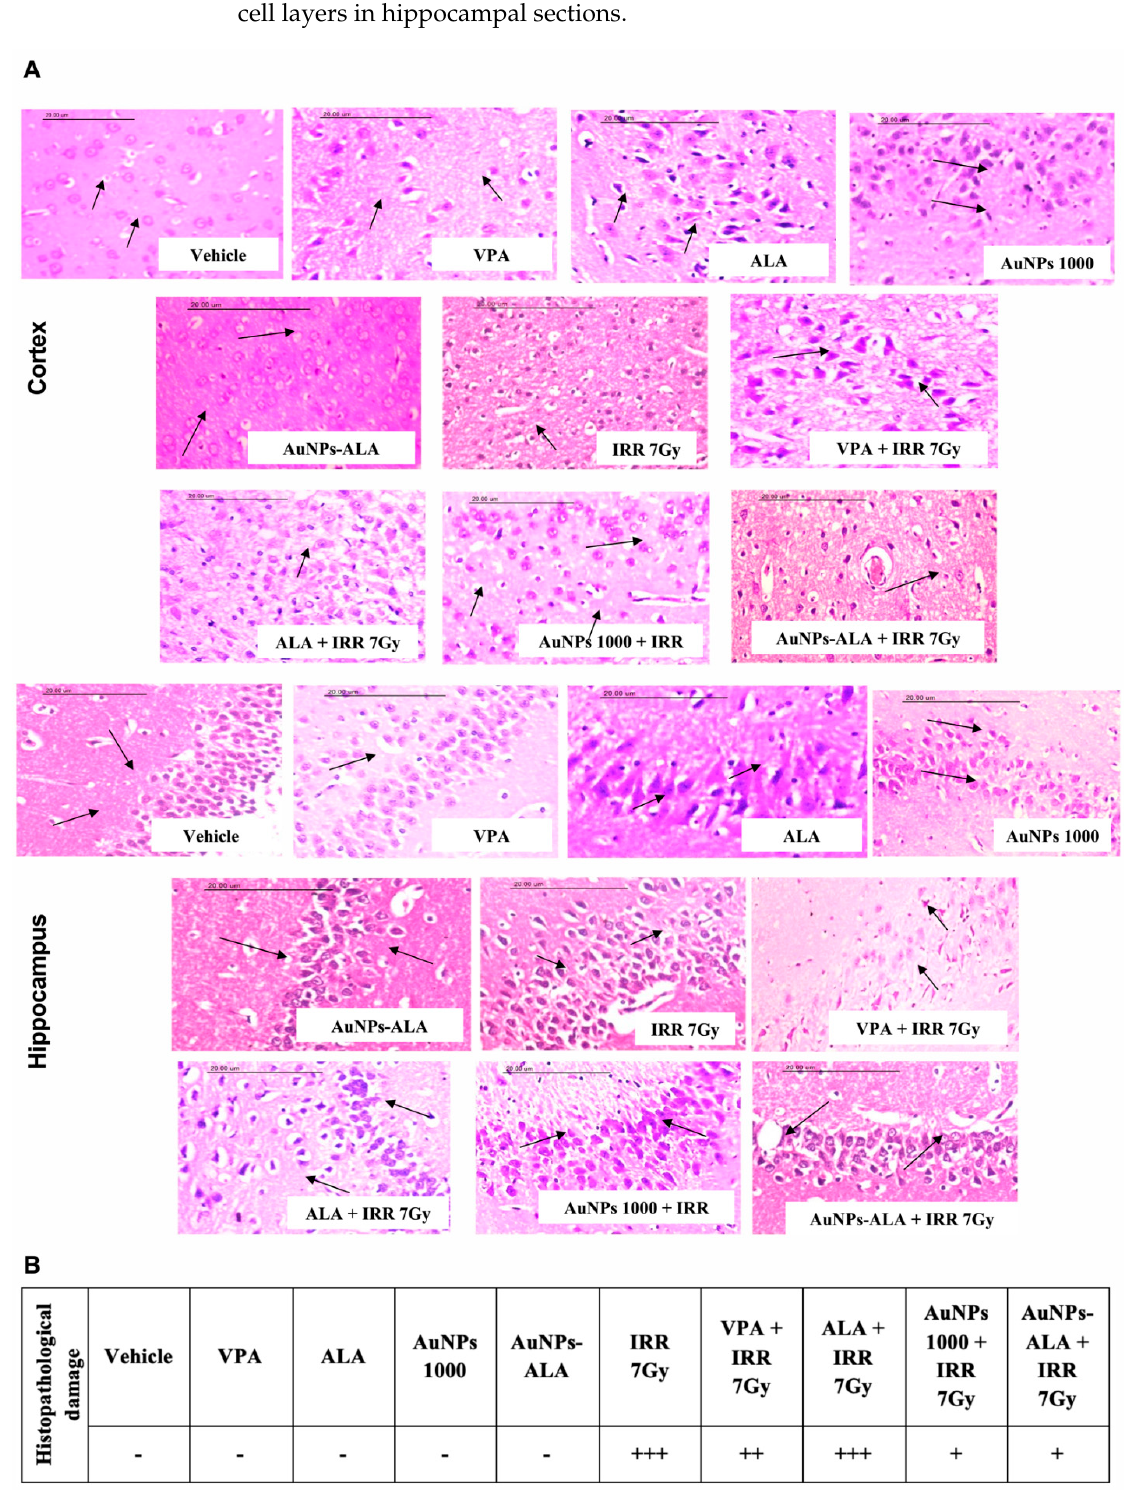
Figure 11. Effect of single oral administration of AuNPs-ALA mixture on histopathological changes in cortical and hippocampal tissues of 7Gy-irradiated rats. ( A ) Sections of cortical and hippocampal specimens stained with H&E (scale bar is 20 µm). ( B ) Table showing the severity of histopathologi- cal damage.